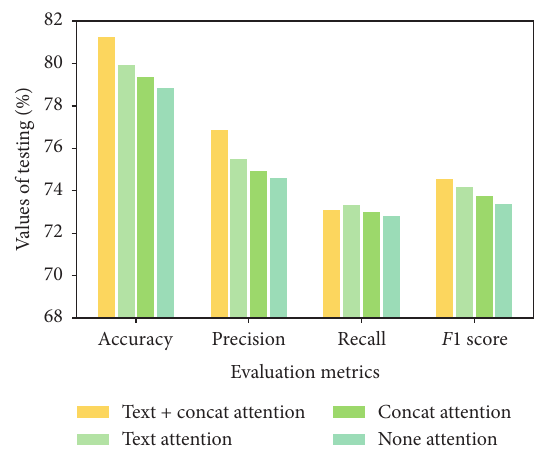
Figure 7: Performance comparison of MSA-UITC and MSA ar- chitecture on the OMD dataset.